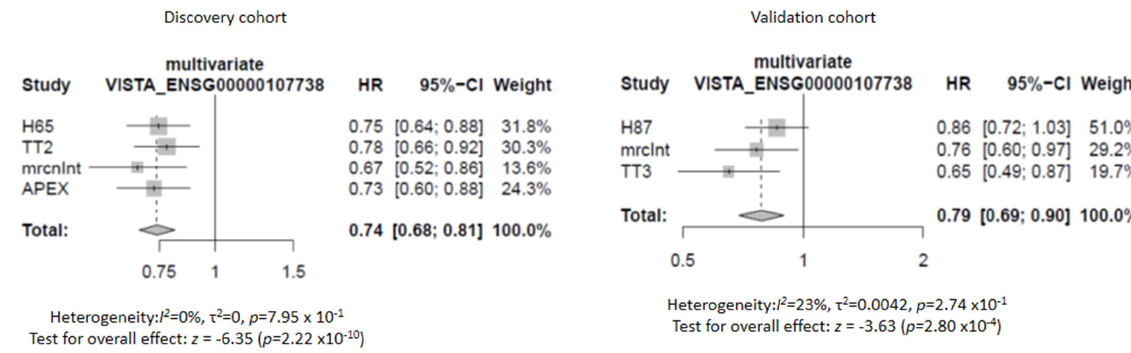
Figure 2. VISTA gene expression relates to OS in MM. Forrest plot showing protective Hazard Ratios (HR) of all trials except TT6 for which data on ISS stage was not available.